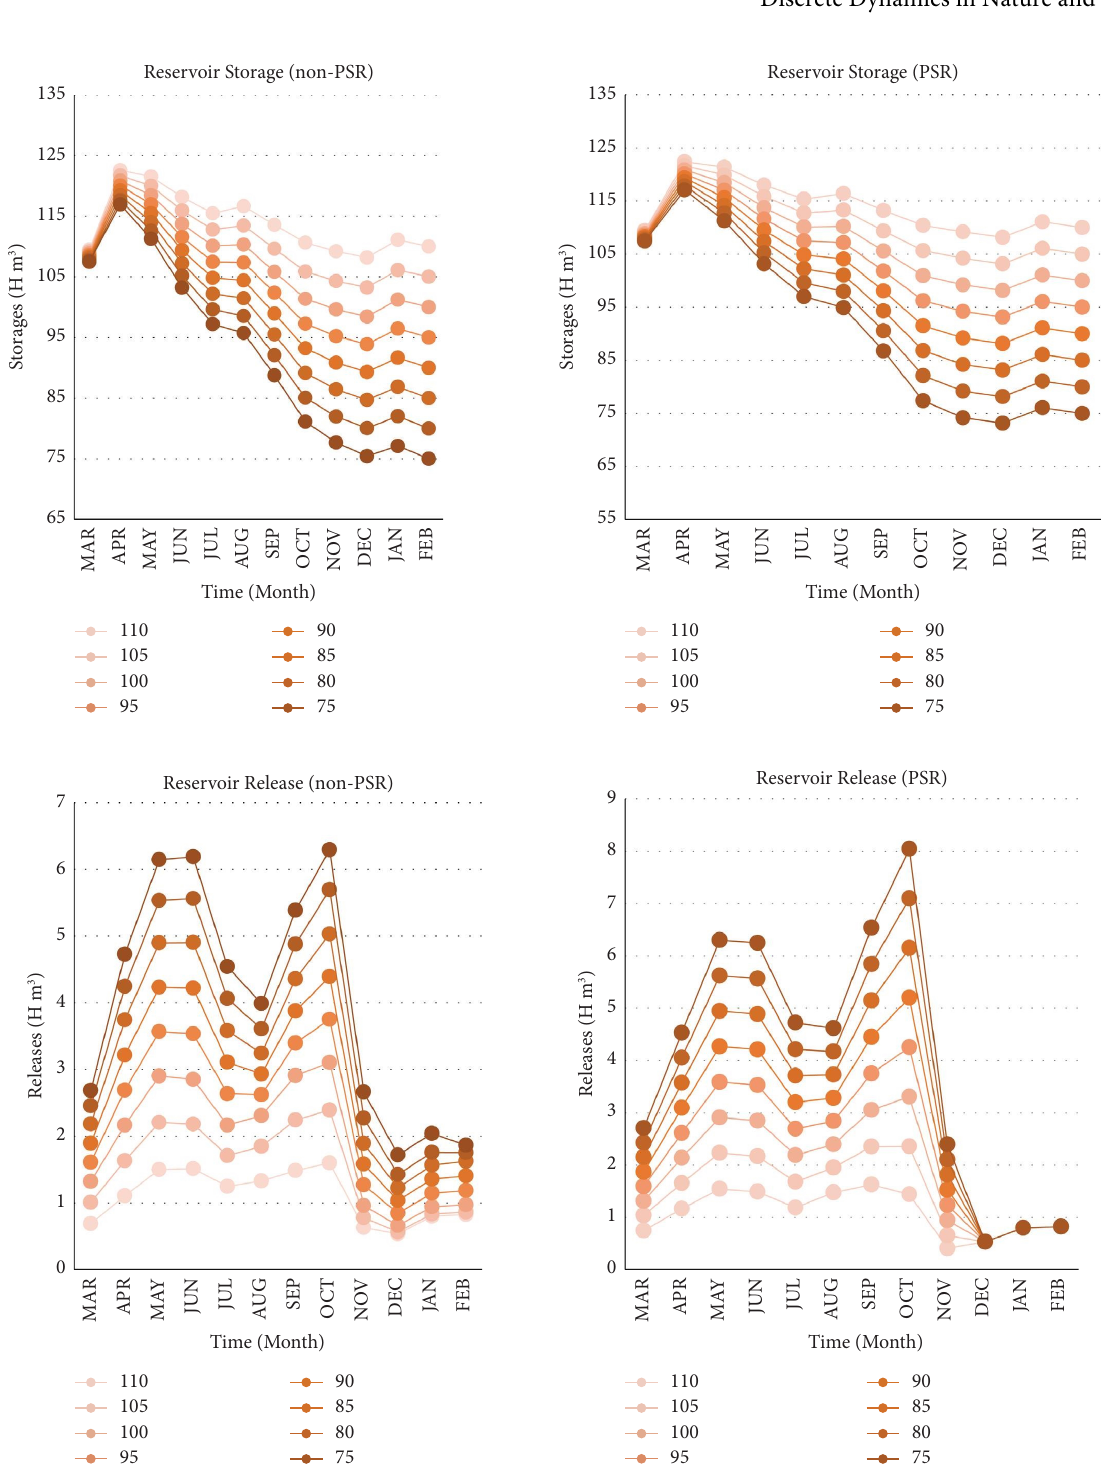
Figure 7: Reservoir storages and releases considering non-PSR and PSR